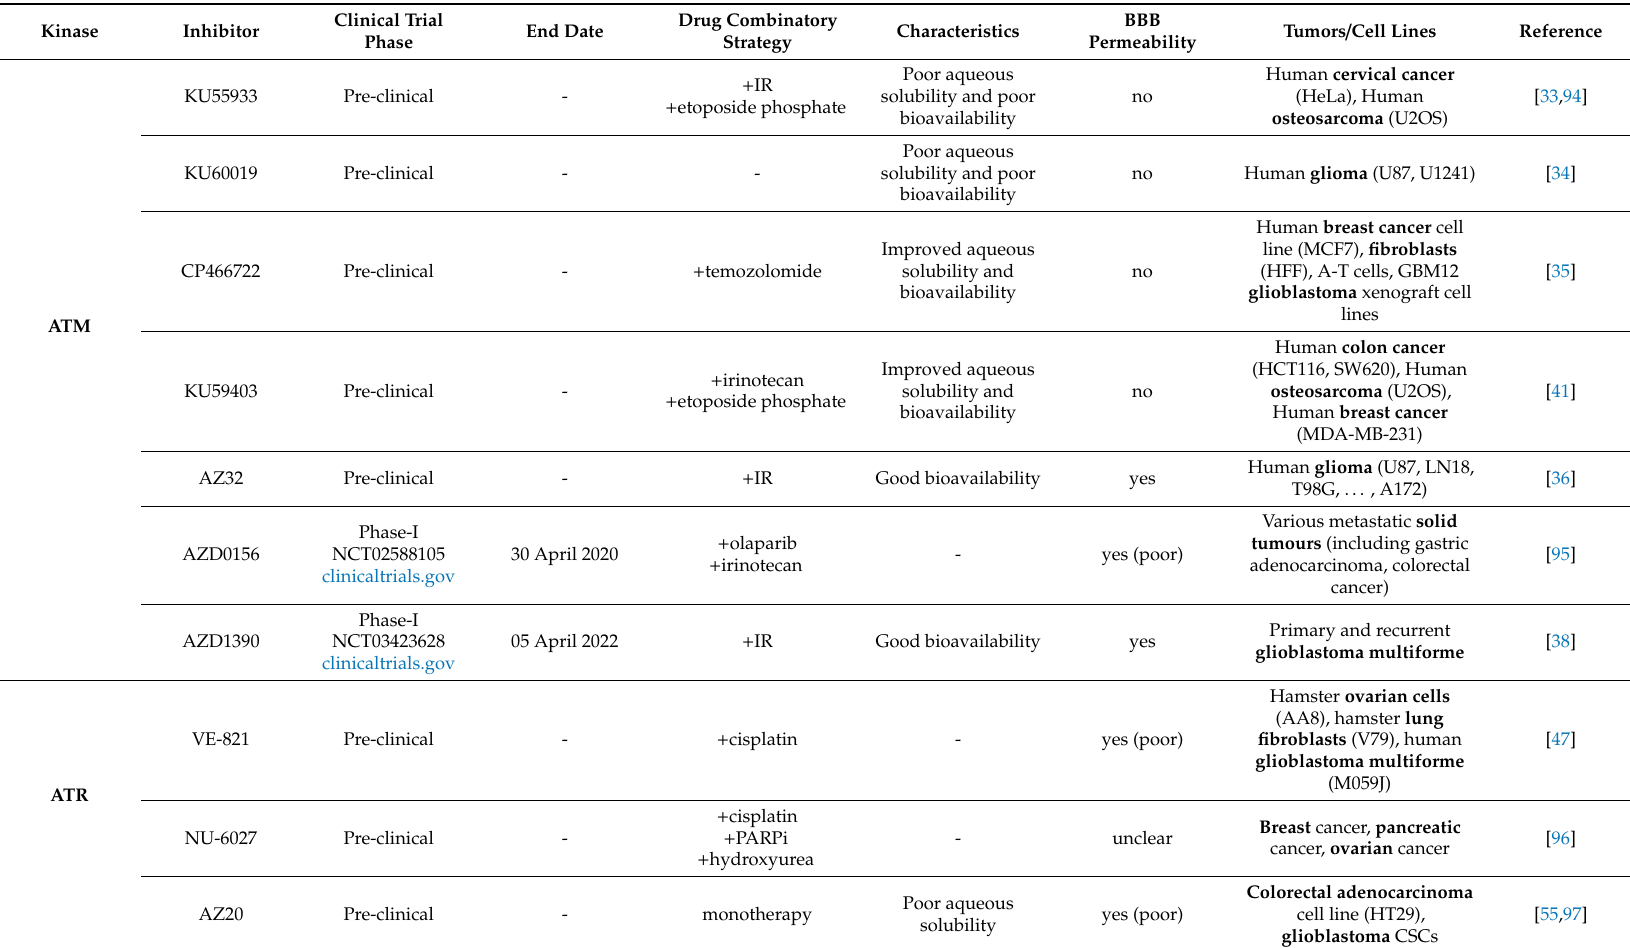
Table 1. Summarizes the main inhibitors that target proteins of the DNA damage response. For each compound, existing clinical trials have been noted, focusing on those involving GBM patients where possible. Further, pharmacologically relevant characteristics such as the drug’s availability and blood–brain barrier (BBB) permeability have been